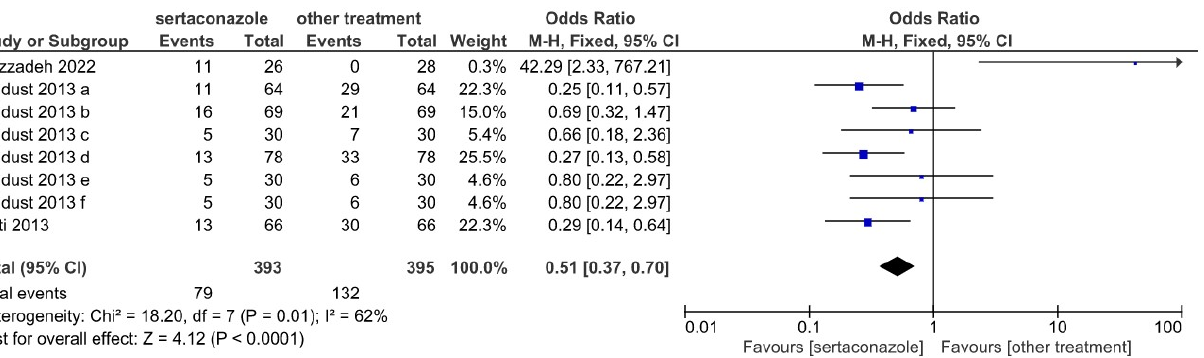
Figure 3. Forrest plot illustrating the effect of sertaconazole vs. other treatments in the eight selected studies for the mild SI at 28 days of treatment (OR with 95% confidence interval, heterogeneity, and overall effect).